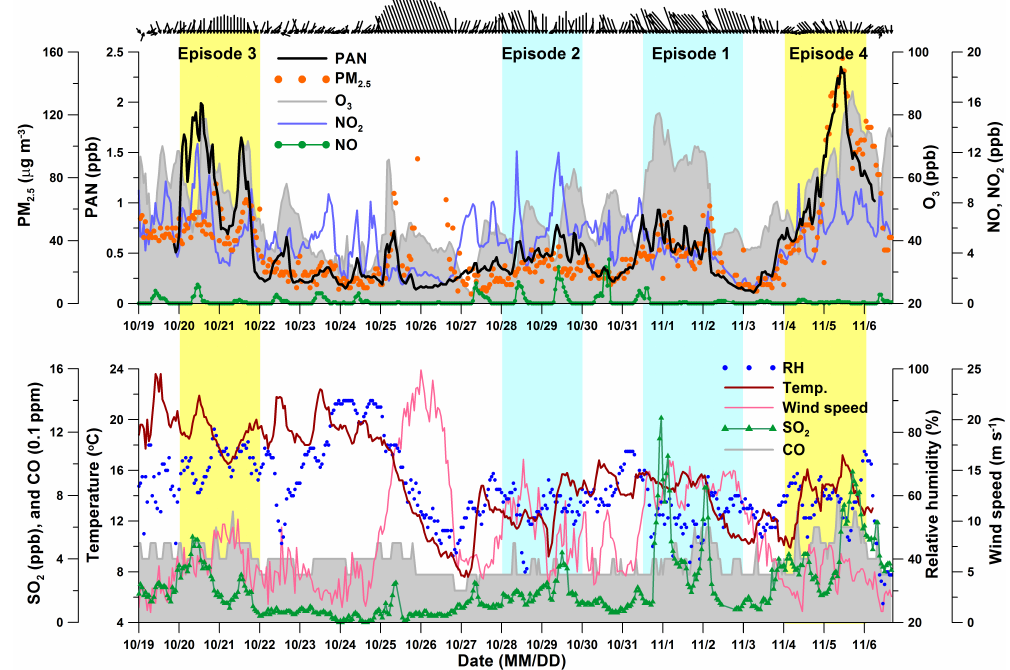
Figure 1. Temporal variations (against local time) of measured species (PAN, PM 2 . 5 , O 3 , NO 2 , NO, SO 2 , and, CO) and meteorological parameters (relative humidity, temperature, and wind speed) in fall 2010. Episodes 1–4, described in the main text, are shaded in blue and